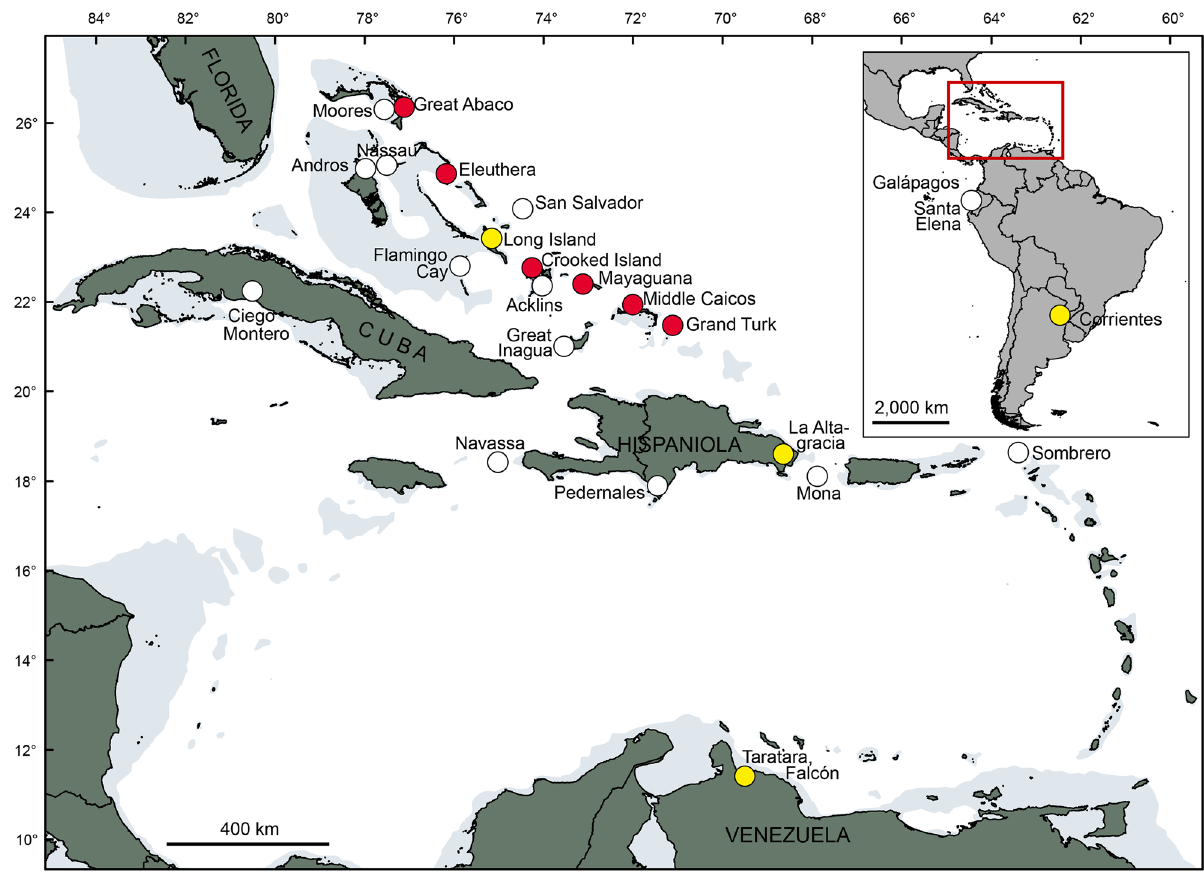
Figure 1. Late Quaternary and Holocene records of large-bodied or giant tortoises ( Chelonoidis spp.) in South America and the Caribbean. Red rectangle in inset map corresponds to enlarged map sector. Open circles: unstudied material 5,6,9–11,21 , yellow circles: samples unsuccessfully processed for aDNA, red circles: samples successfully processed for aDNA. Grey areas show the shelf to a depth of 200 m. Map was created using ArcGIS 10.4 (https ://www.esri.com/en-us/arcgi s/about -arcgi s/overv iew) and Adobe Illustrator CS6 (http://www.adobe .com/produ cts/illus trato